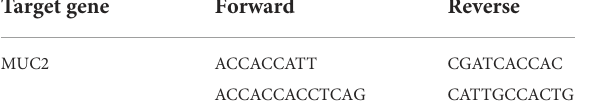
TABLE 1 Primer sequence. Target